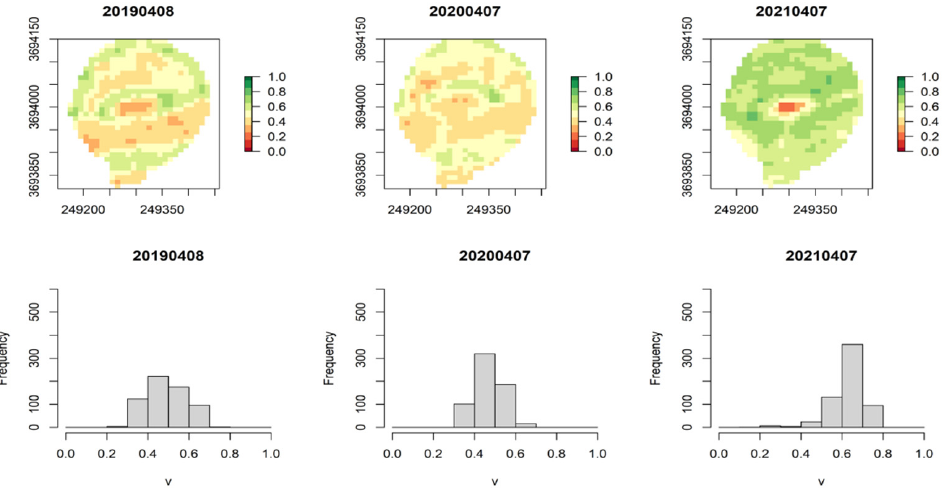
Figure 2. NDVI variation in April of 2019 to 2021 with varying temperatures.